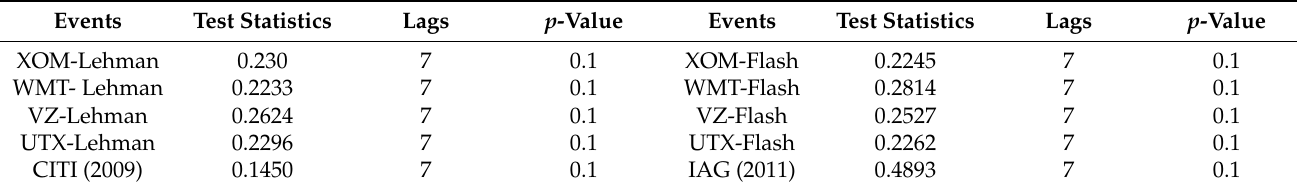
Table 2. KPSS t-statistics